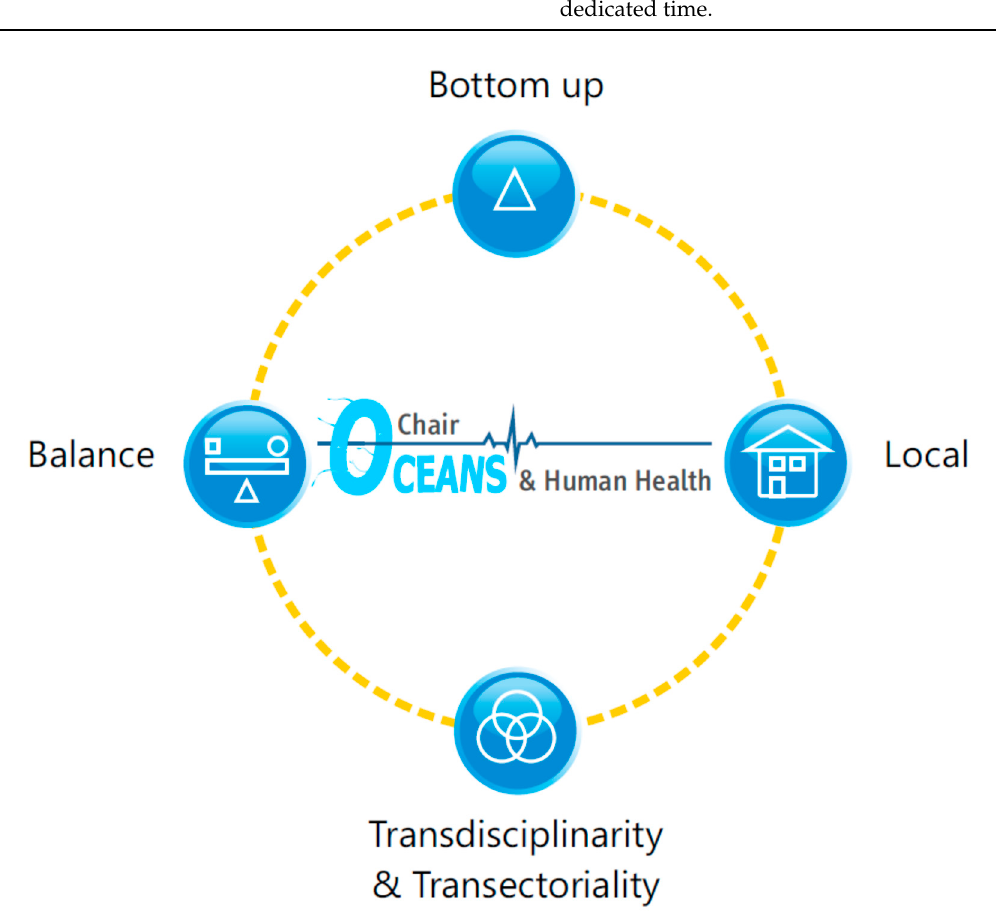
Figure 5. The relevant principles resulting from the OHH Chair to foster new participatory process in oceans and human health.